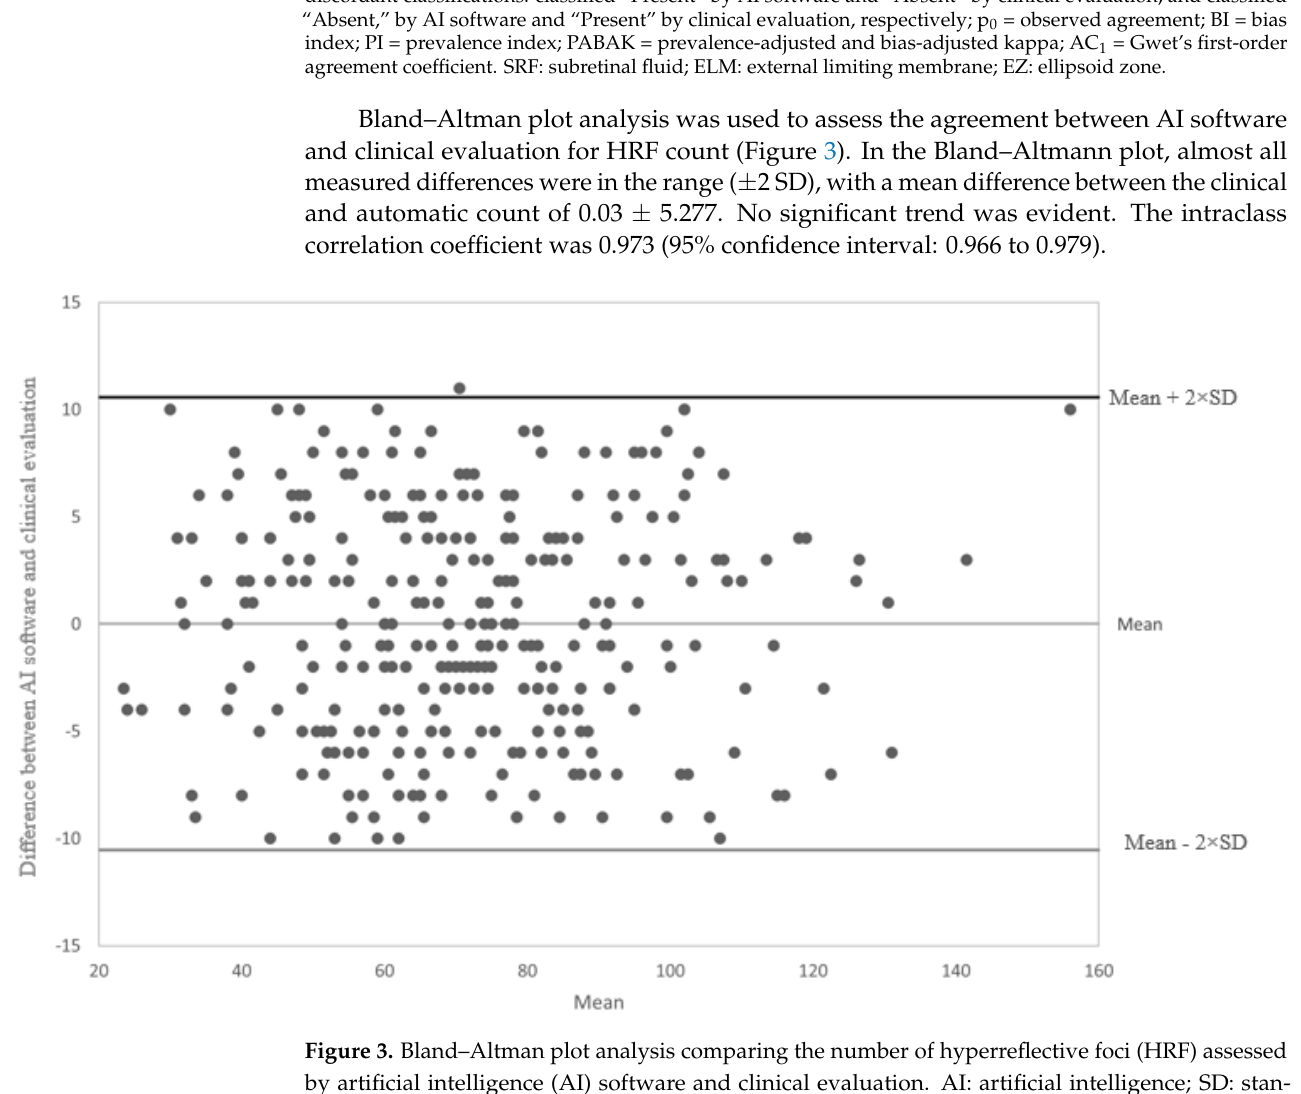
Table 3. Inter-rater agreement κ between artificial intelligence (AI) software and clinical evaluation.